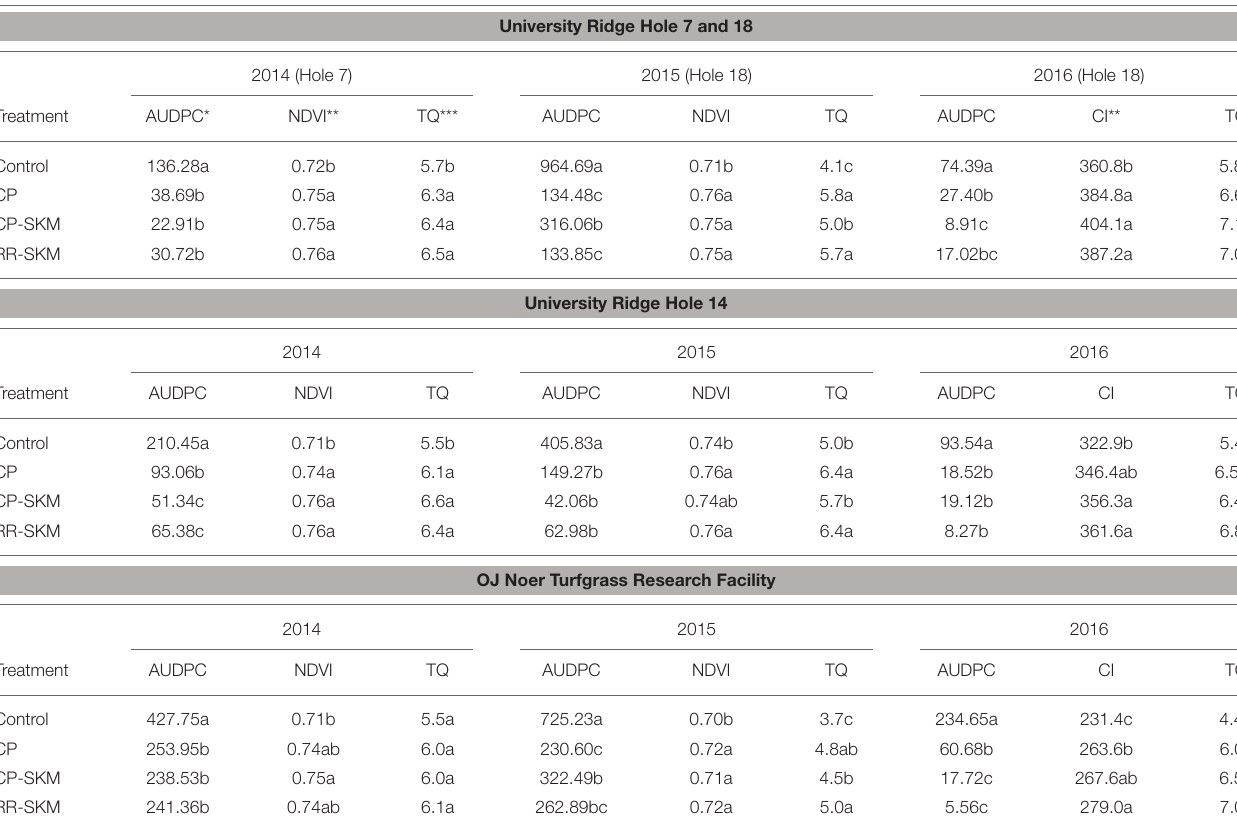
TABLE 4 | Area under the disease progress curve (AUDPC), turfgrass color, and turfgrass quality (TQ) for the Smith-Kerns model reduced risk study conducted at University Ridge Golf Course and the O. J. Noer Turfgrass Research Facility in Verona, Wisconsin, USA between 2014 and 2016.